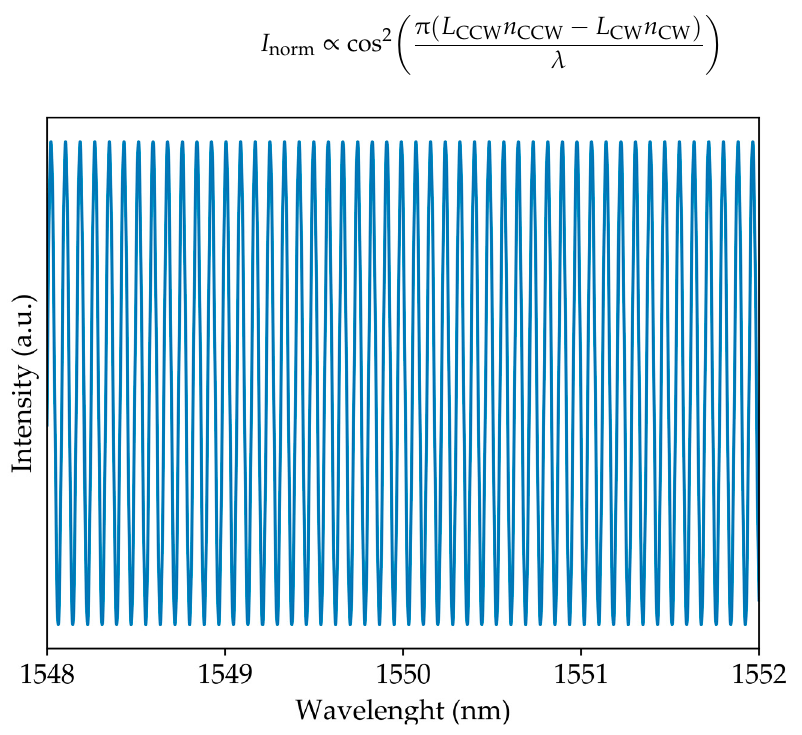
Figure 2. Simulation of an interferometer with Δ L = 20.25 mm.